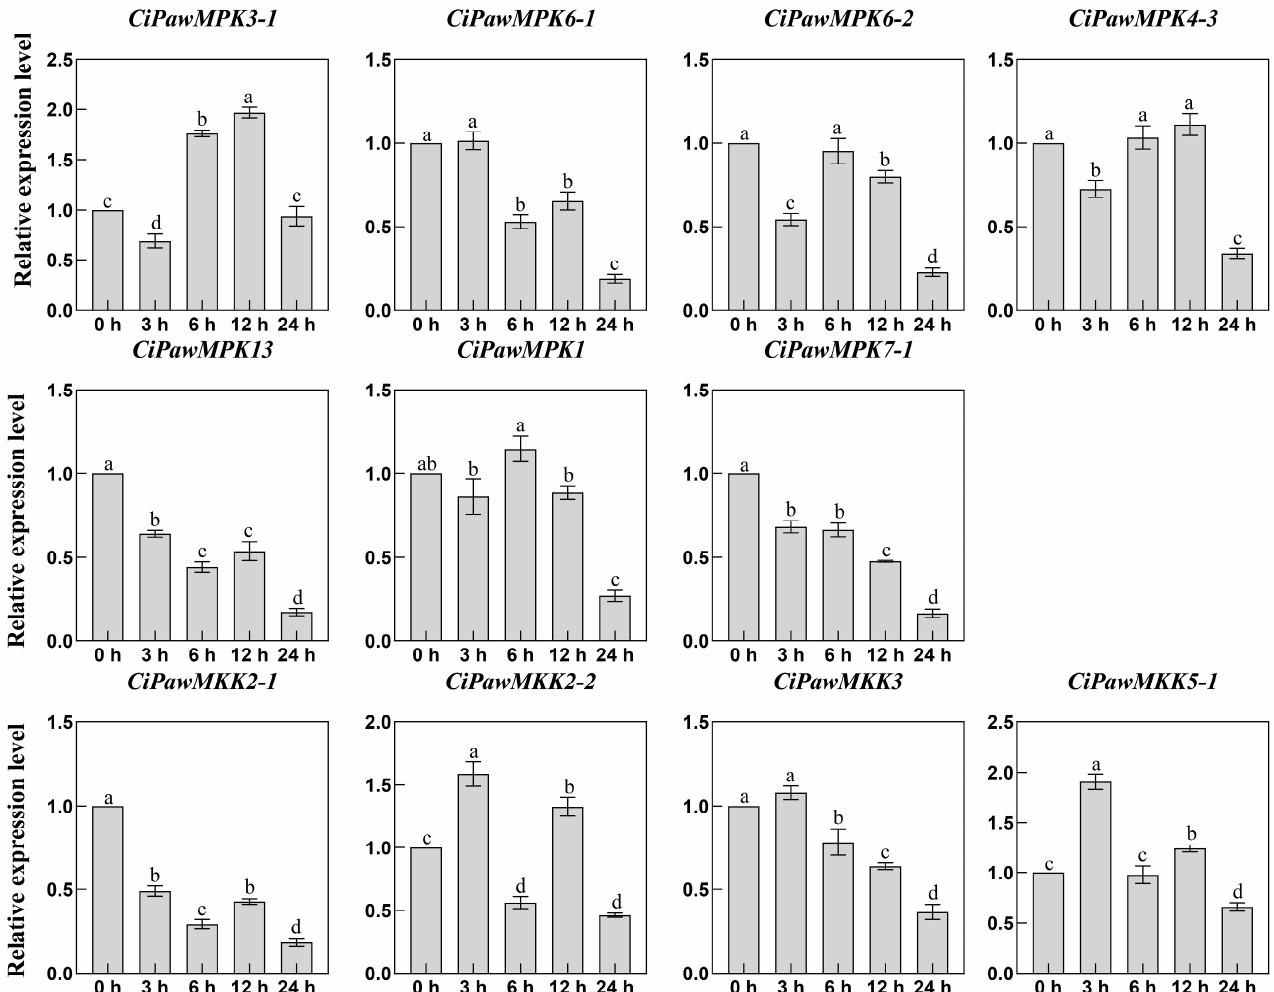
Figure 10. Gene expression patterns of MPK and MKK in pecan under H 2 O 2 stress. The reference gene is the actin gene ( CiPaw.03G124400 ). The horizontal coordinates indicate the different time points sampled and the vertical coordinates indicate the expression level of the genes. According to Duncan’s multiple range test, it was judged whether there was a significant difference in the expression levels at different time points ( p < 0.05), and the difference results were denoted by lowercase letters. Error bars represent mean ± SE obtained from three biological replicates.